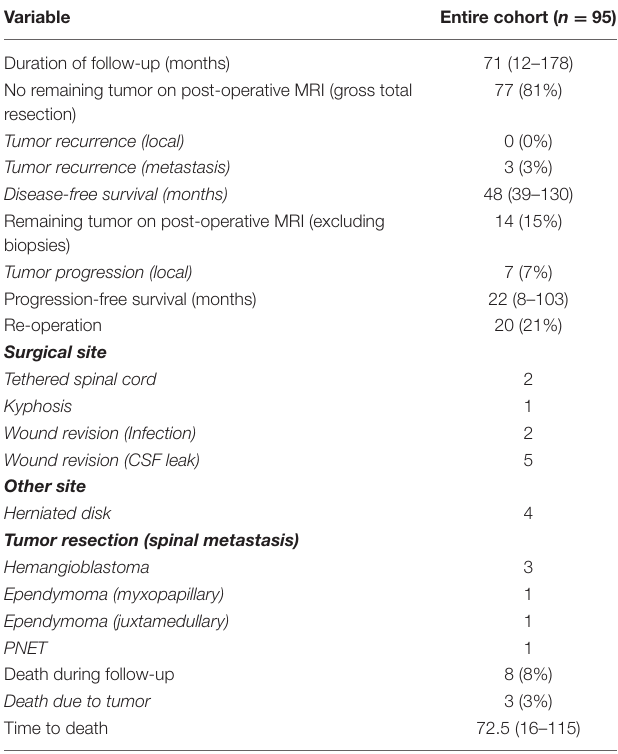
TABLE 4 | Treatment